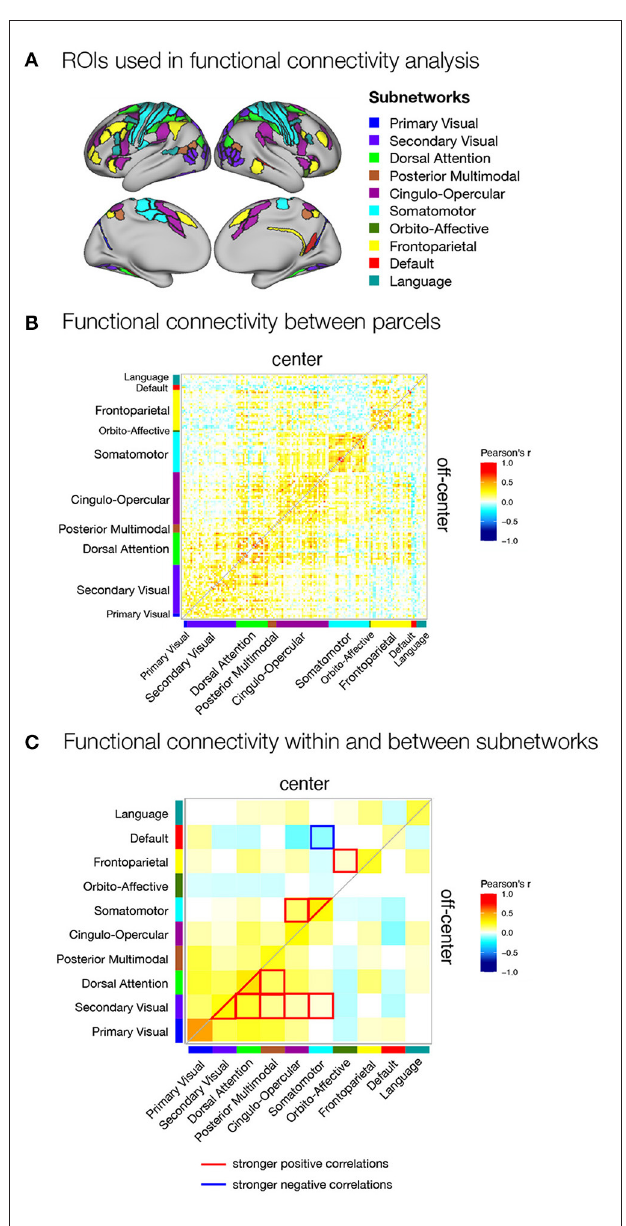
FIGURE 5 | Functional connectivity within the spatial working memory network during the delay period of center and off-center conditions in Experiment II. (A) ROIs selected for functional connectivity analysis. ROIs were identified based on activation analysis as any region that was active during the delay period of any of the task conditions or showed differences in delay activity between the same task conditions. ROIs were then assigned to subnetworks as described by Ji et al. (2019). Functional connectivity during the delay (B) between individual parcels for each task condition and (C) between subnetworks for each task condition and differences between task conditions. As a measure of functional connectivity, we calculated Pearson’s correlation coefficients between the delay activity of individual ROIs or specific subnetworks. Statistically significant correlations were identified using permutation analysis, using FDR to control for multiple comparisons and thresholding results at q < 0.05. The resulting correlation matrices are not symmetric: they show Pearson’s correlation coefficients for the center condition in the upper triangle and for the off-center condition in the lower